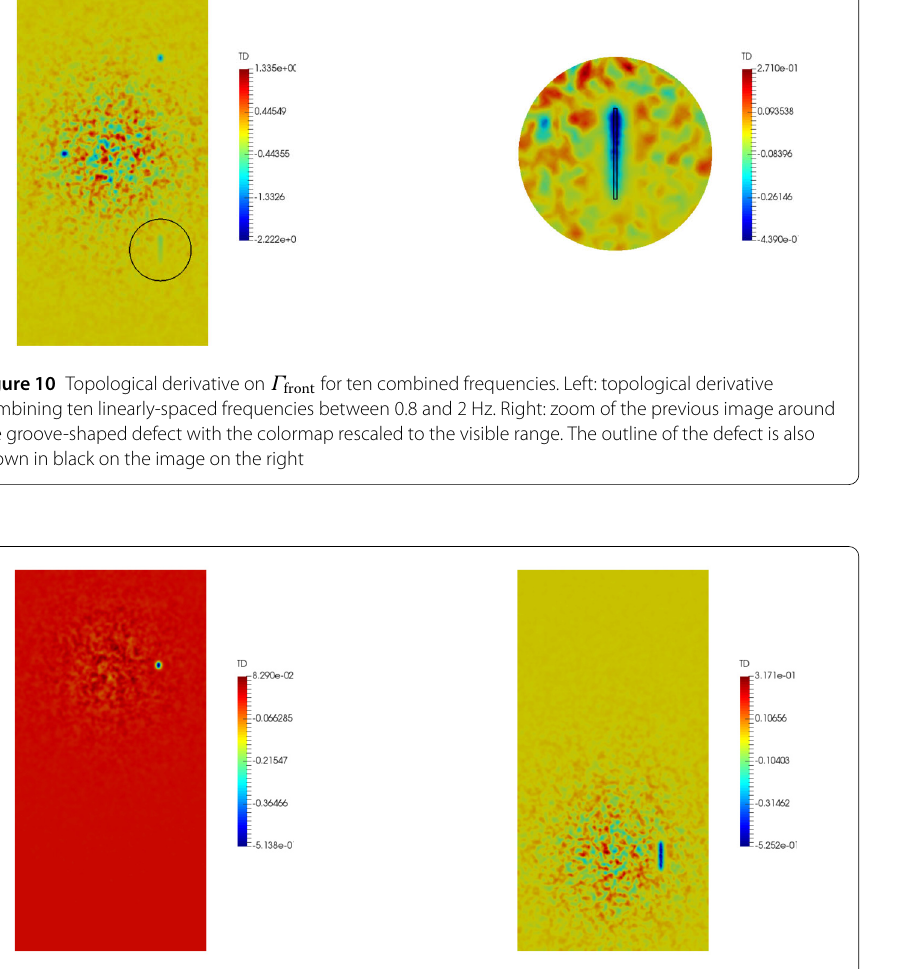
Figure 11 Topological derivative on Γ front for two different lamp locations. Left: lamp near the box-shaped defect. Right: lamp near the groove-shaped defect. As one can see, reconstructions highly depend on the position of the